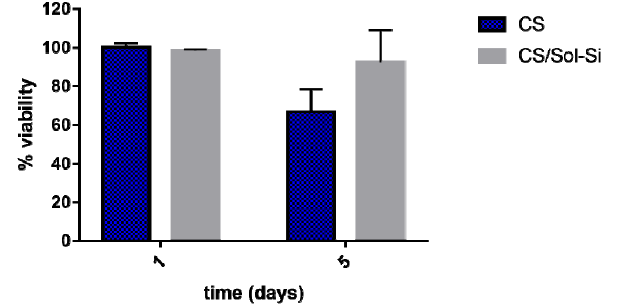
Figure 6. Percentage of viability of [3T3] mouse fibroblasts after incubation with CS and CS/Sol-Si at 1 and 5 days, by the MTT assay. Data are expressed as percentage relative to control. Data are shown as mean ± SD of triplicate experiments.